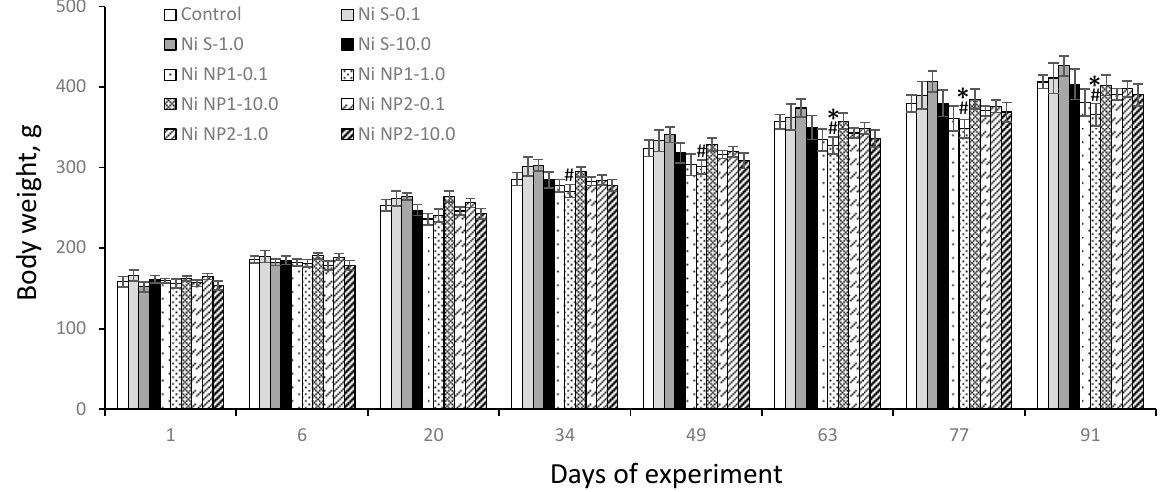
Figure 4. Estimated actual doses of Ni NPs preparations consumed by rats during the 92-day exper-